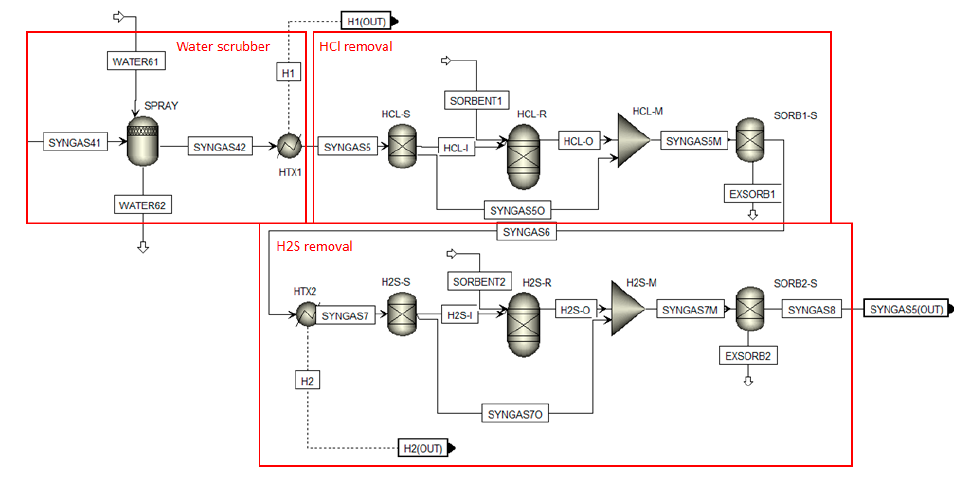
Figure 4. Syngas cleaning unit .